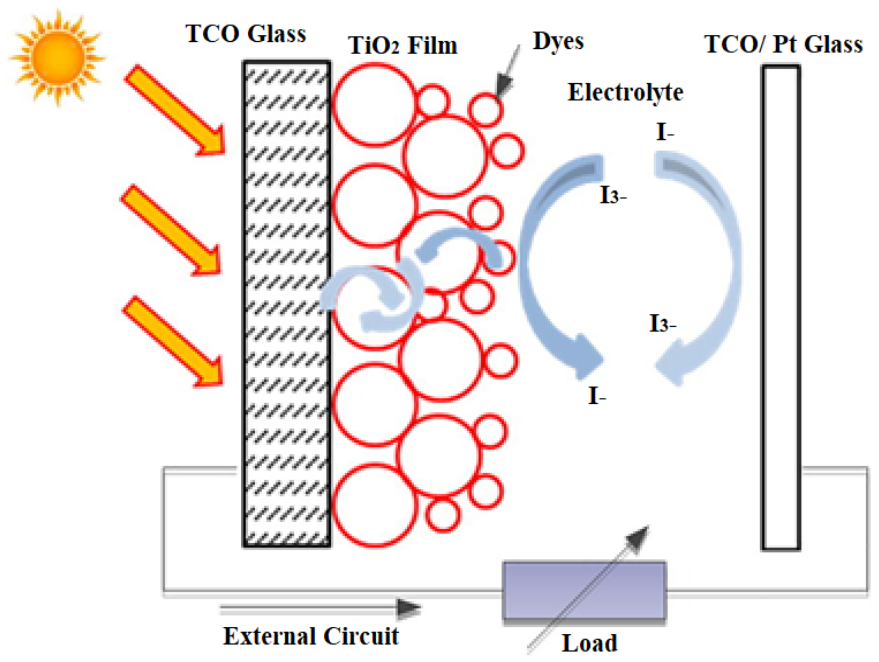
Figure 13. Schematic representation of a DSSCs [2].